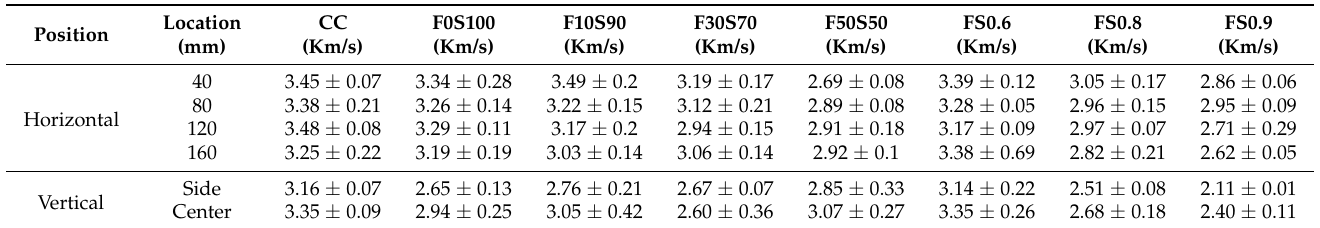
Table 3. Ultrasonic pulse velocity (UPV) values of preplaced aggregate concrete